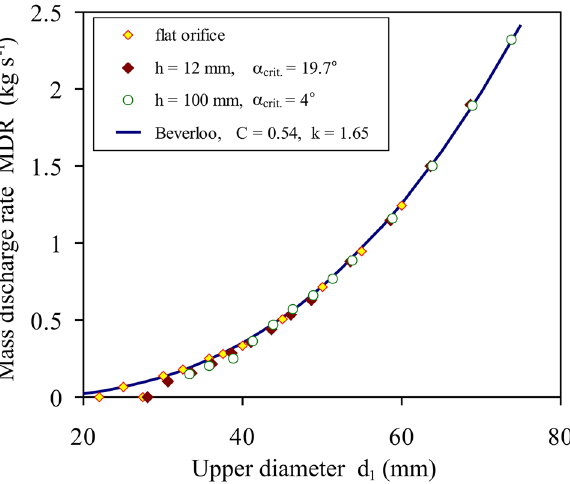
Figure 6. Comparison of simulated MDR ( d 1 ) relationships performed for the flat orifice and two values of the orifice thickness h of the converging orifice and the half cone angle α crit. providing the maximum discharge rate with predictions of Beverloo’s equation.